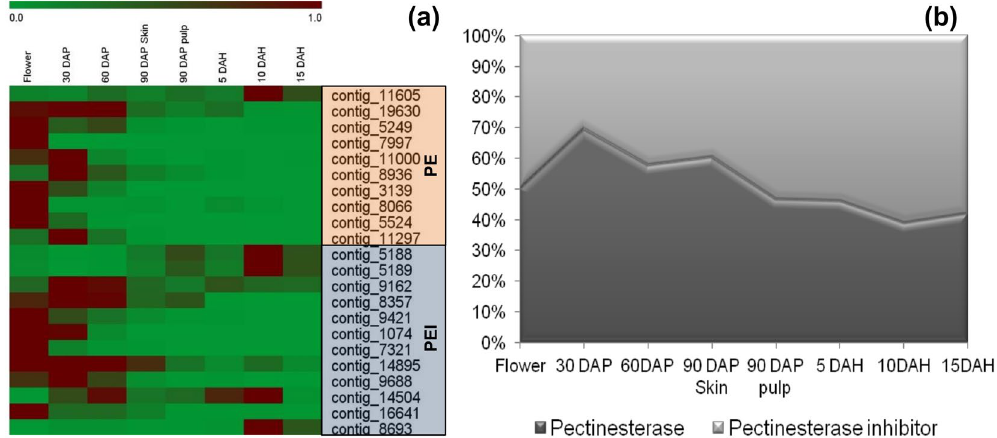
Figure 10. ( a ) Heatmap representing expression profiles of contigs encoding pectinesterase (PE) and pectinesterase inhibitor (PEI) from RNAseq data. ( b ) Representation of percent co-expression (Y-axis) of 10 contigs encoding pectinesterase and 12 contigs encoding pectinesterase inhibitor, respectively by calculating sum of their mapped raw reads in various tissues of Alphonso mango